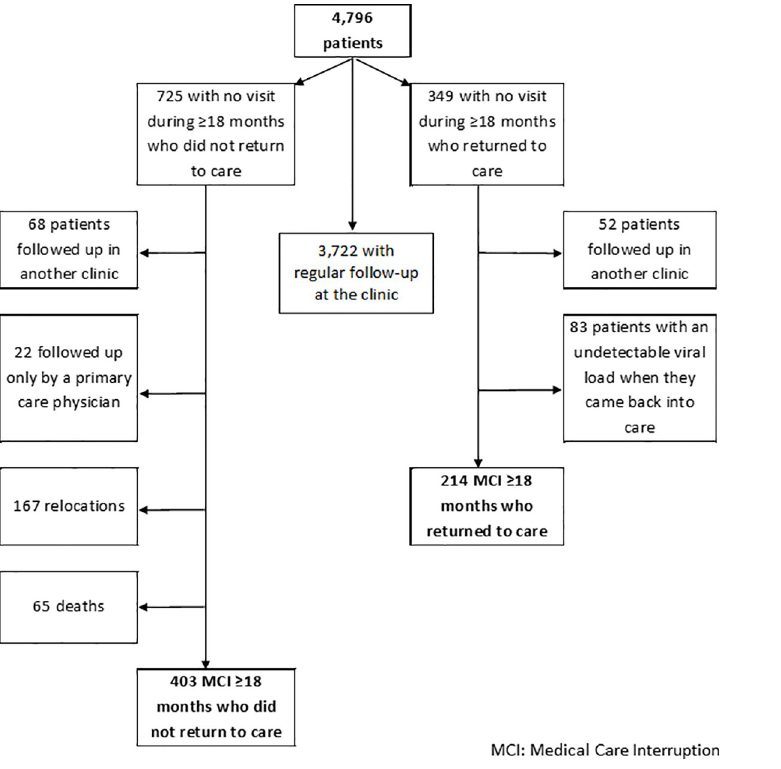
Fig 2. Future of HIV-infected patients with no health care visit for at least 18 months.